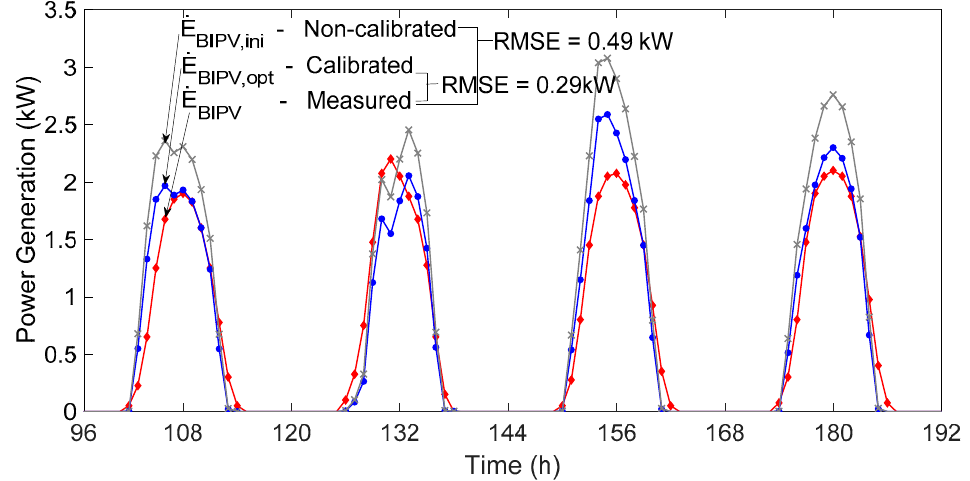
Figure 11. Power production of calibrated and noncalibrated models for unused in situ test data (last four days).